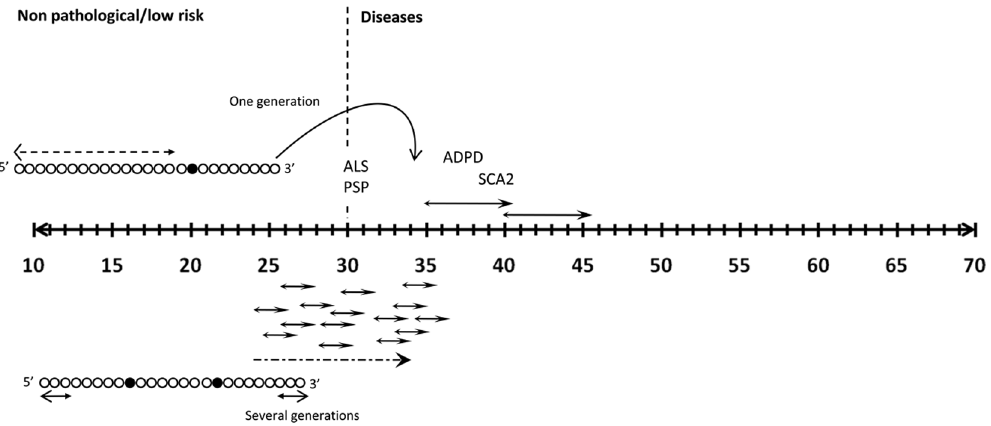
Figure 6. General mechanisms for ATXN2 gene denovo mutagenesis in the population. Two models can be proposed for explanation of de novo CAG expansions in ATXN2 . Both involve loss of the CAA interruption in large alleles resulting in a minimal length of pure repeat within the CAG expansion. CAA interruptions break the CAG tract in discrete repeat arrays protecting it from instability [17]. According to this study, the minimal length of the internal pure repeat leading to de novo mutations is 8 CAG.